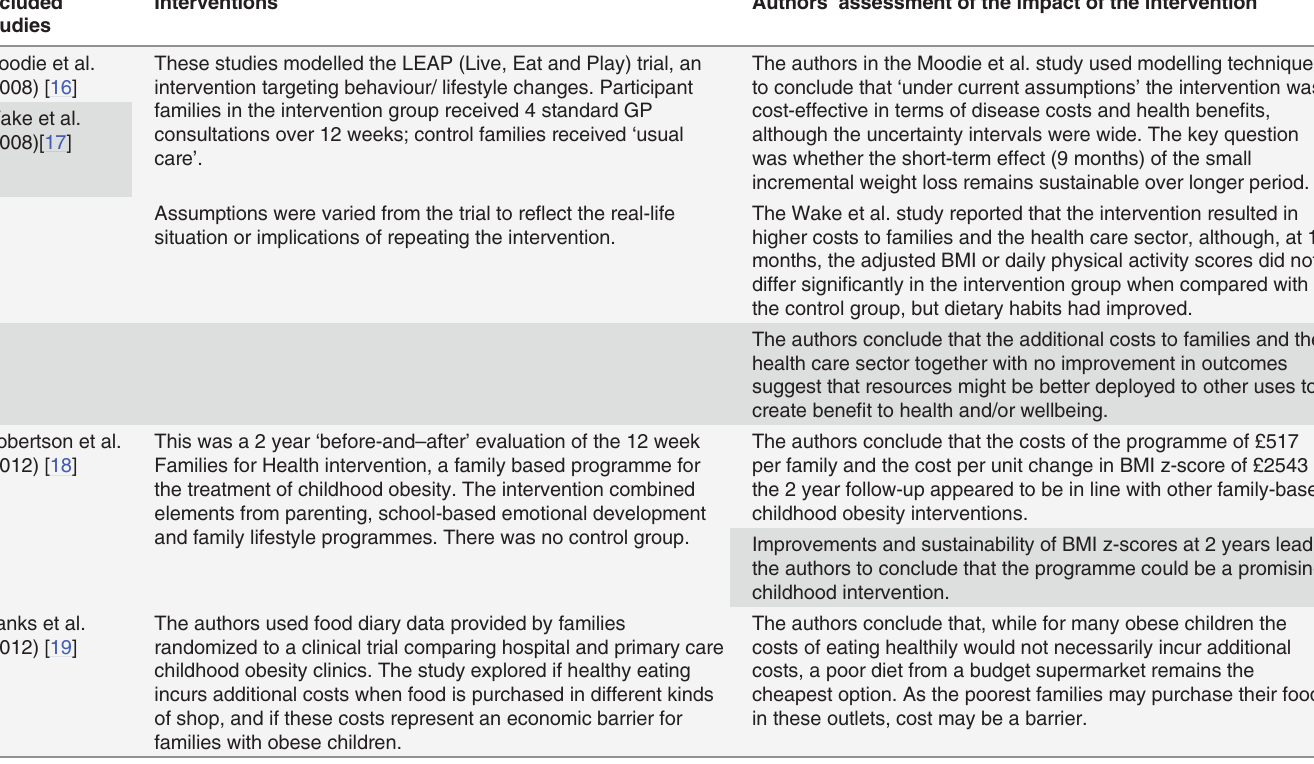
Table 1. Overview of studies meeting inclusion criteria and authors ’ assessment of the impact of the intervention.